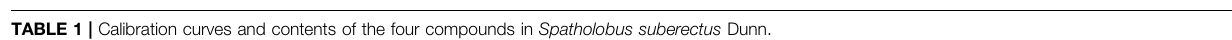
TABLE 1 | Calibration curves and contents of the four compounds in Spatholobus suberectus Dunn.